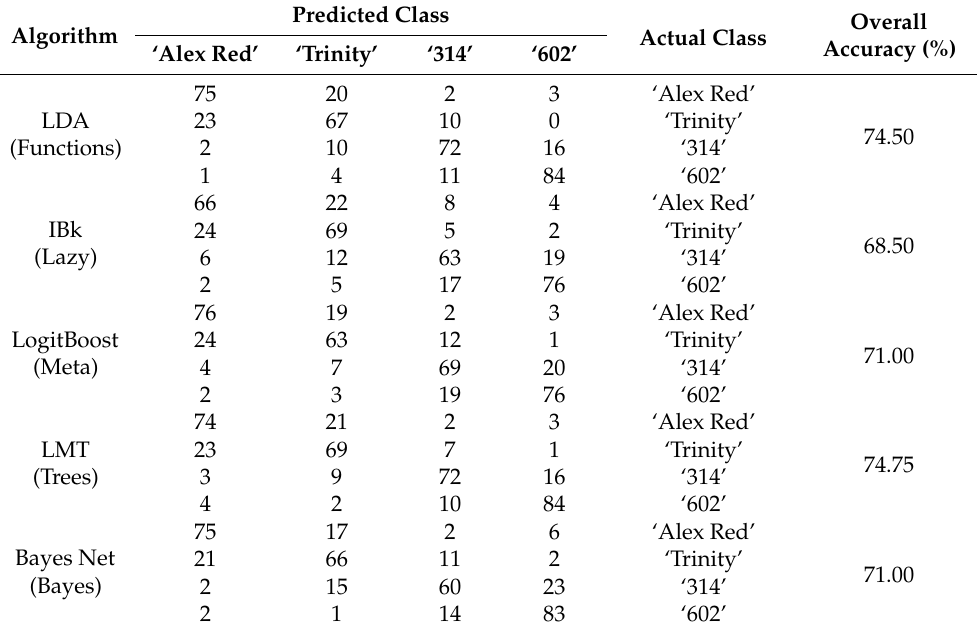
Table 6. The number of correctly and incorrectly classified cases and overall accuracies of the classification of freeze-dried red-fleshed apple cubes based on selected image textures.